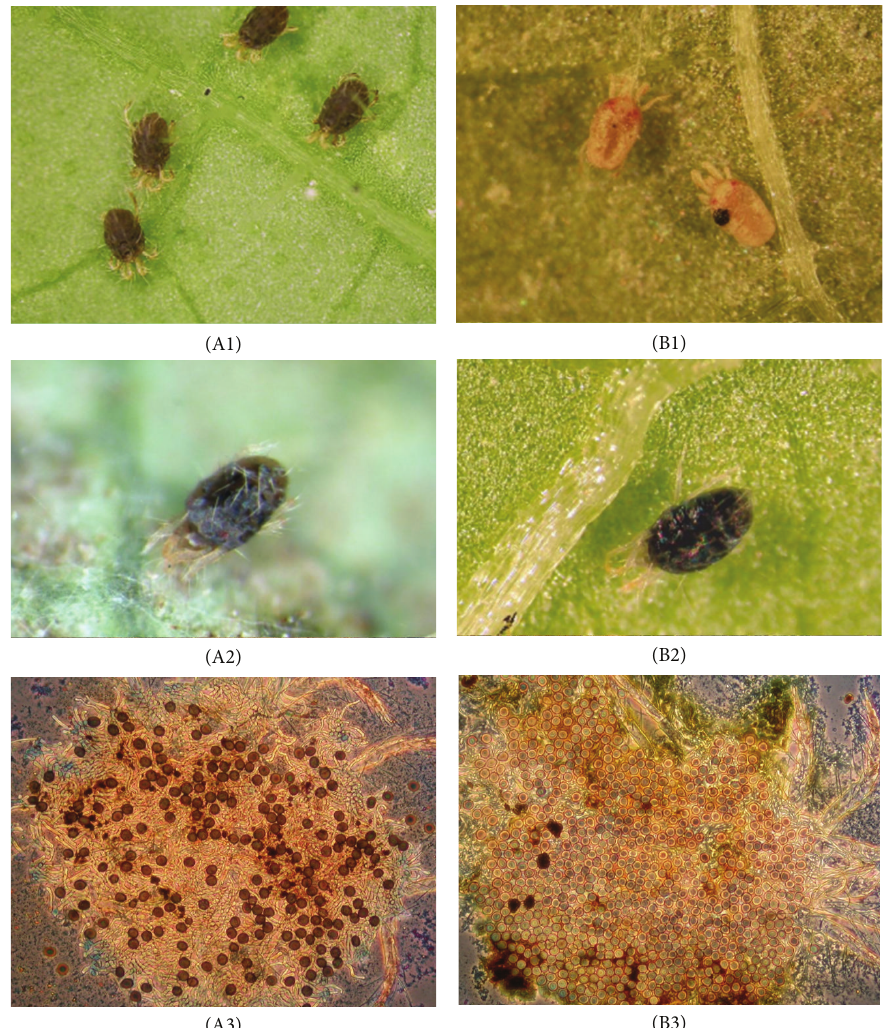
Figure 1: T. urticae killed by the fungus N. floridana . A(1–3) Norwegian isolate (NCRI271/04), (A1) dark brown cadavers with hyphal bodies, (A2) black/dark brown cadaver with resting spore, (A3) mature resting spores in squash mount, B(1–3) Brazilian isolate (ESALQ1420), (B1) light brown/orange cadavers with hyphal bodies, (B2) black/dark brown cadaver with resting spores, (B3) almost mature resting spores in squash